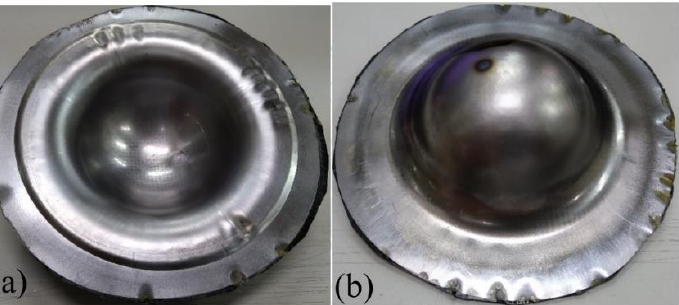
Figure 16. Deep drawing of steel-composite sandwich with blank-holding pressure of 3.5 MPa: ( a ) front view, ( b ) back view.